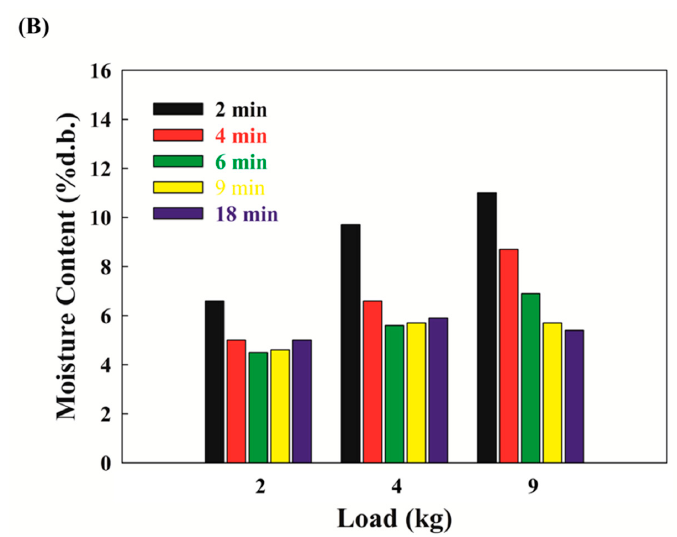
Figure 2. Profiles of the moisture content ( A ) and the changes in the moisture content ( B ) of wheat germ with different WG loadings. The symbols represent the experimental data; the lines represent the simulated values.